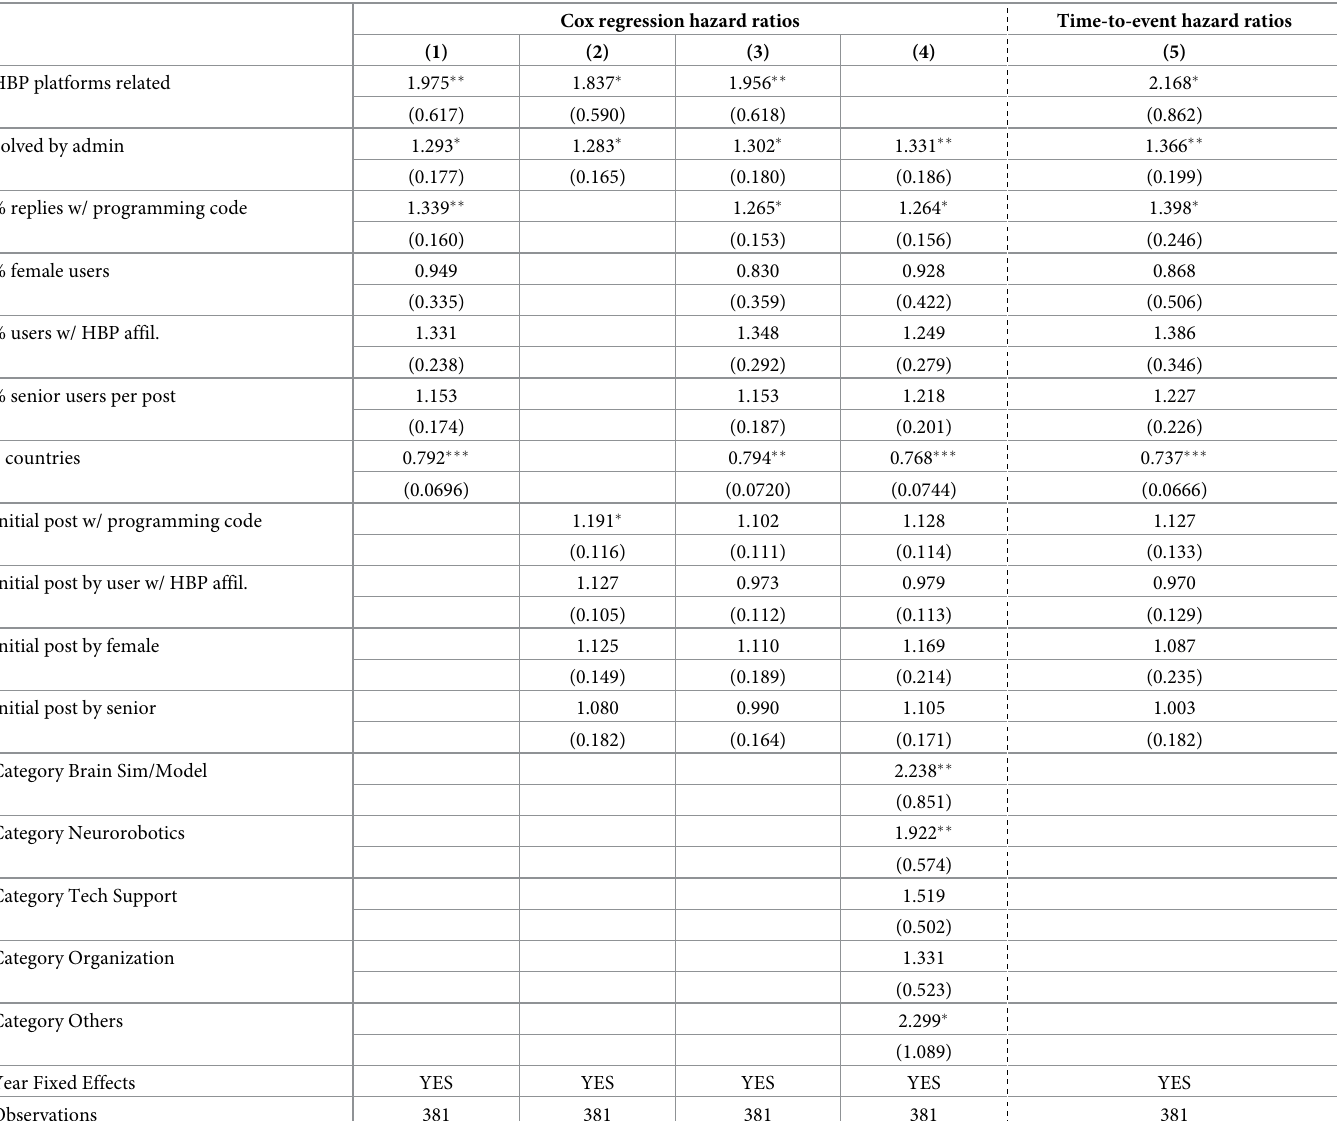
Table 3. Cox proportional hazard analyses and time-to-event